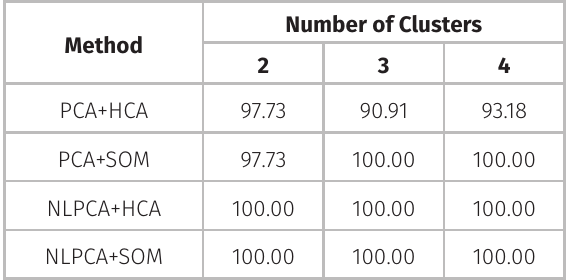
Table III Classification accuracy (%) of gauge stations – Discriminant analysis